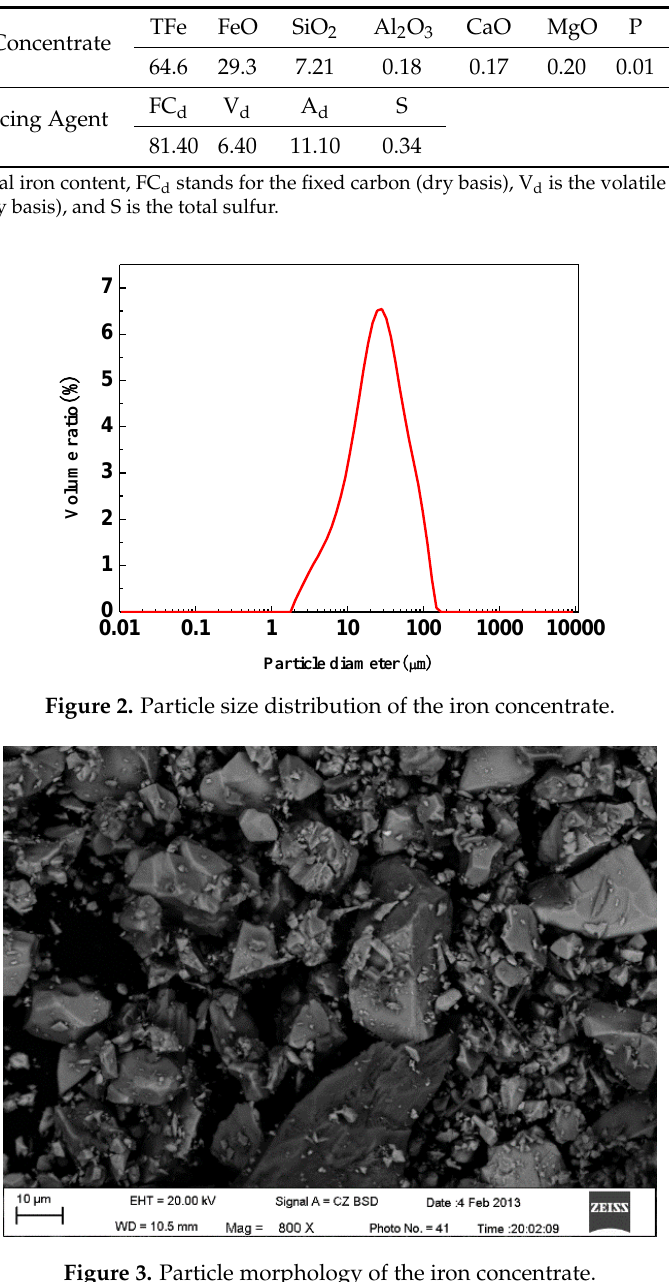
Figure 3. Particle morphology of the iron concentrate. Table 1. Chemical composition of the raw materials (wt %).